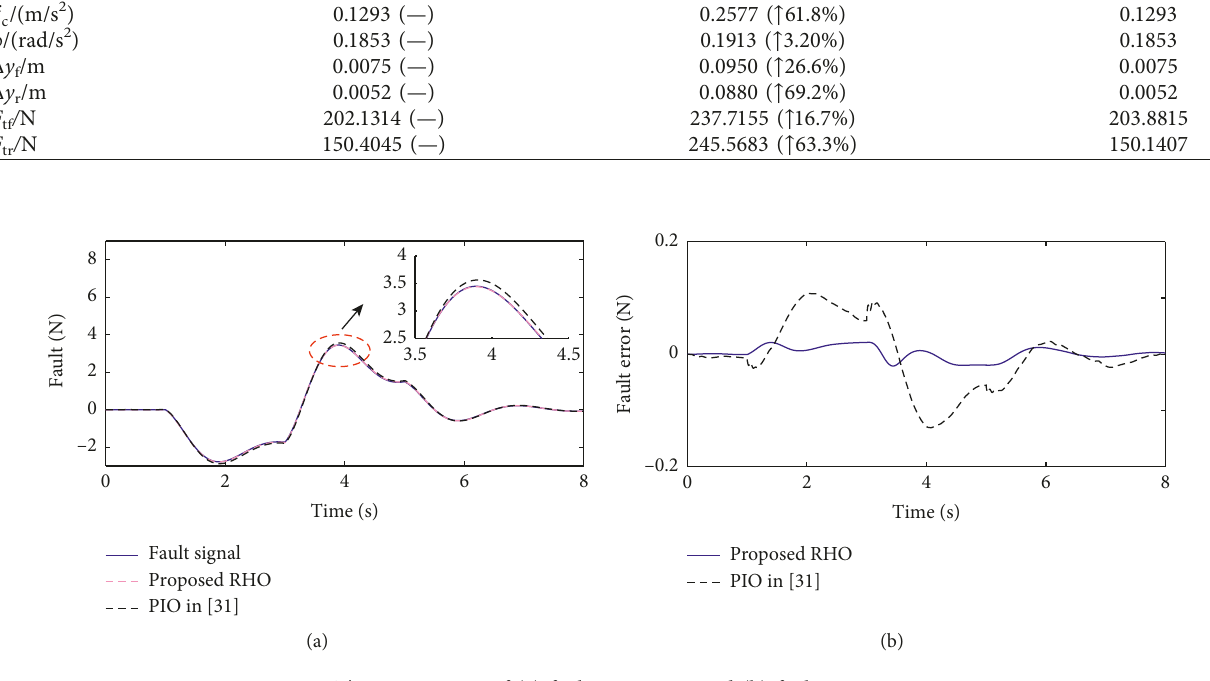
Figure 9: The comparison of (a) fault estimation and (b) fault estimation error.